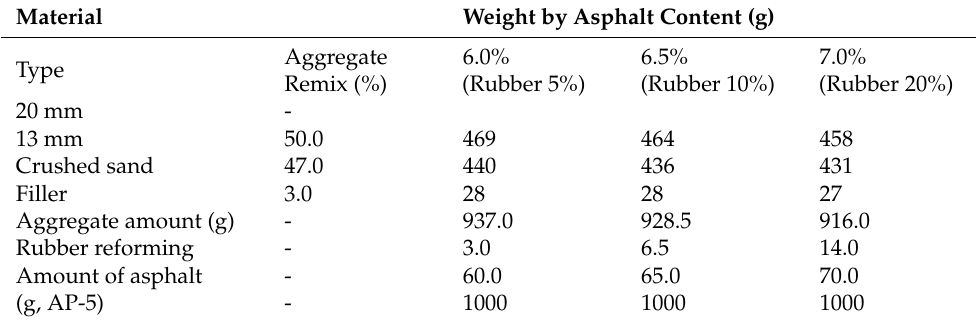
Table 4. Material amount